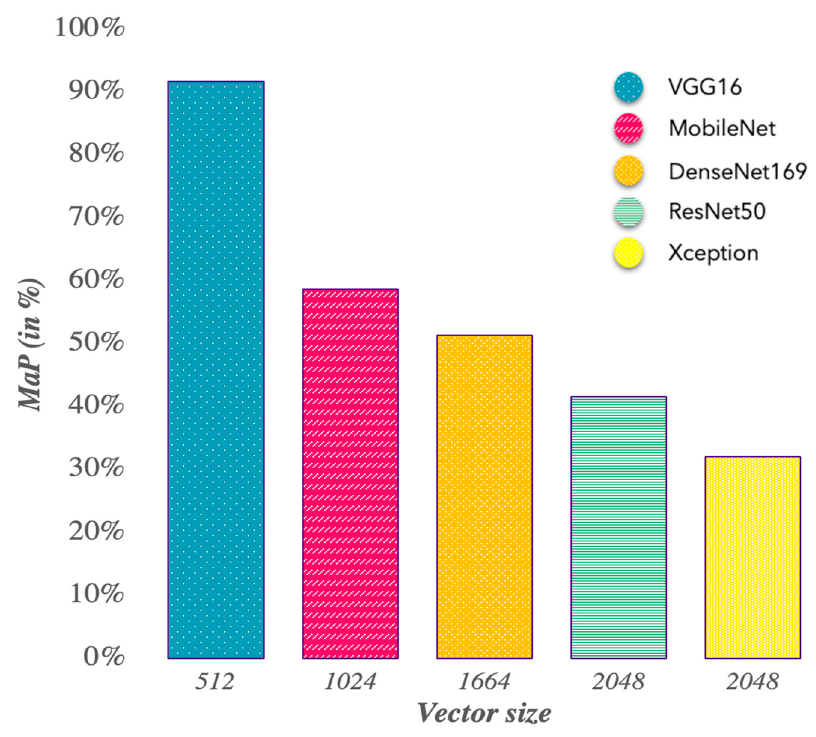
Figure 13. Results MaP in the function of RMAC+ vector size.